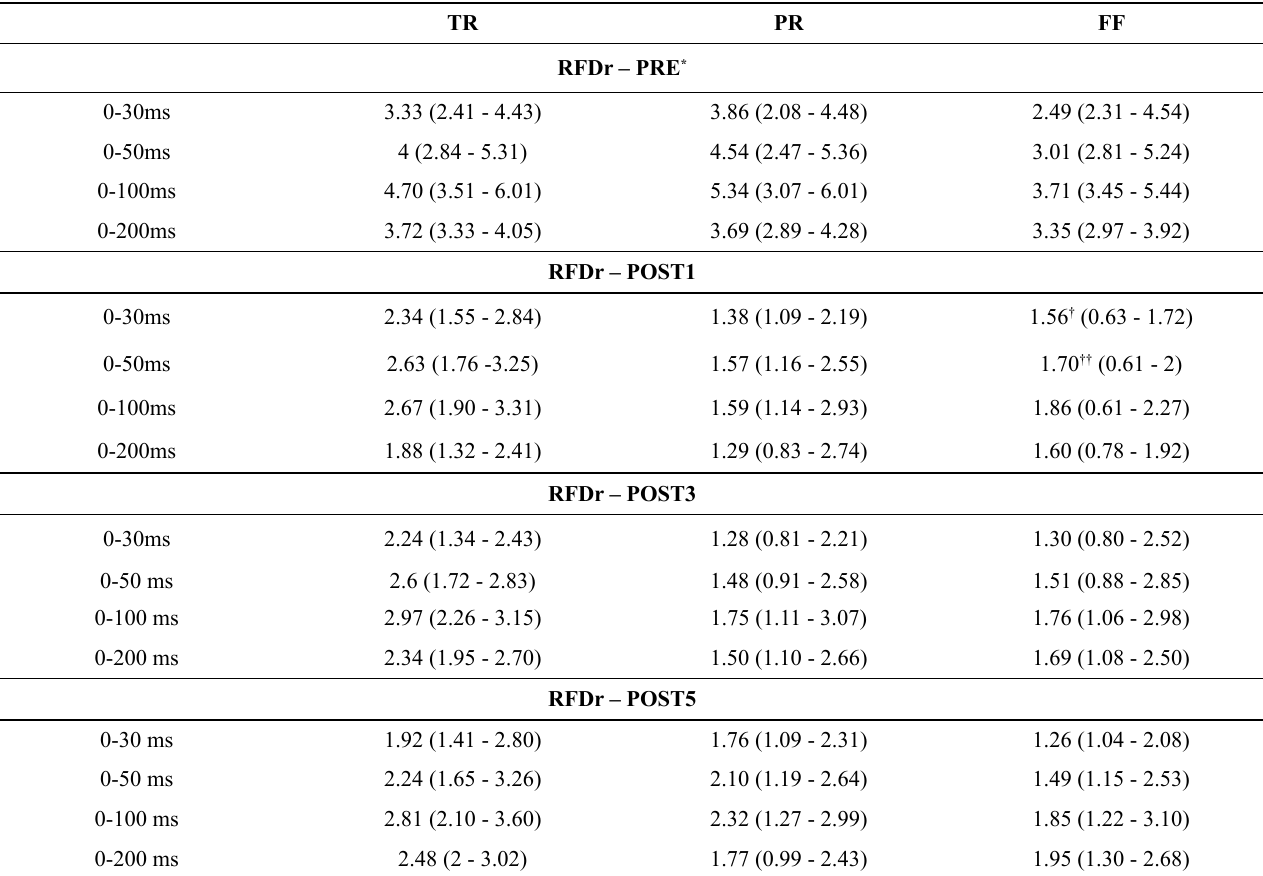
Table 2. The relative rate of force development (%MVIF∙s-1) obtained before (PRE) and post 1 (POST1), 3 (POST3), and 5 (POST5) minutes after task failure at TR, PR and FF conditions. TR